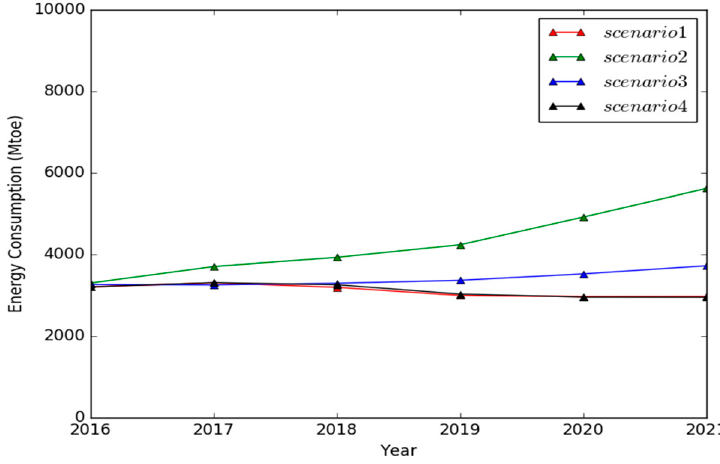
Figure 4. The forecasting results of Chinese energy consumption (2016–2021 year).